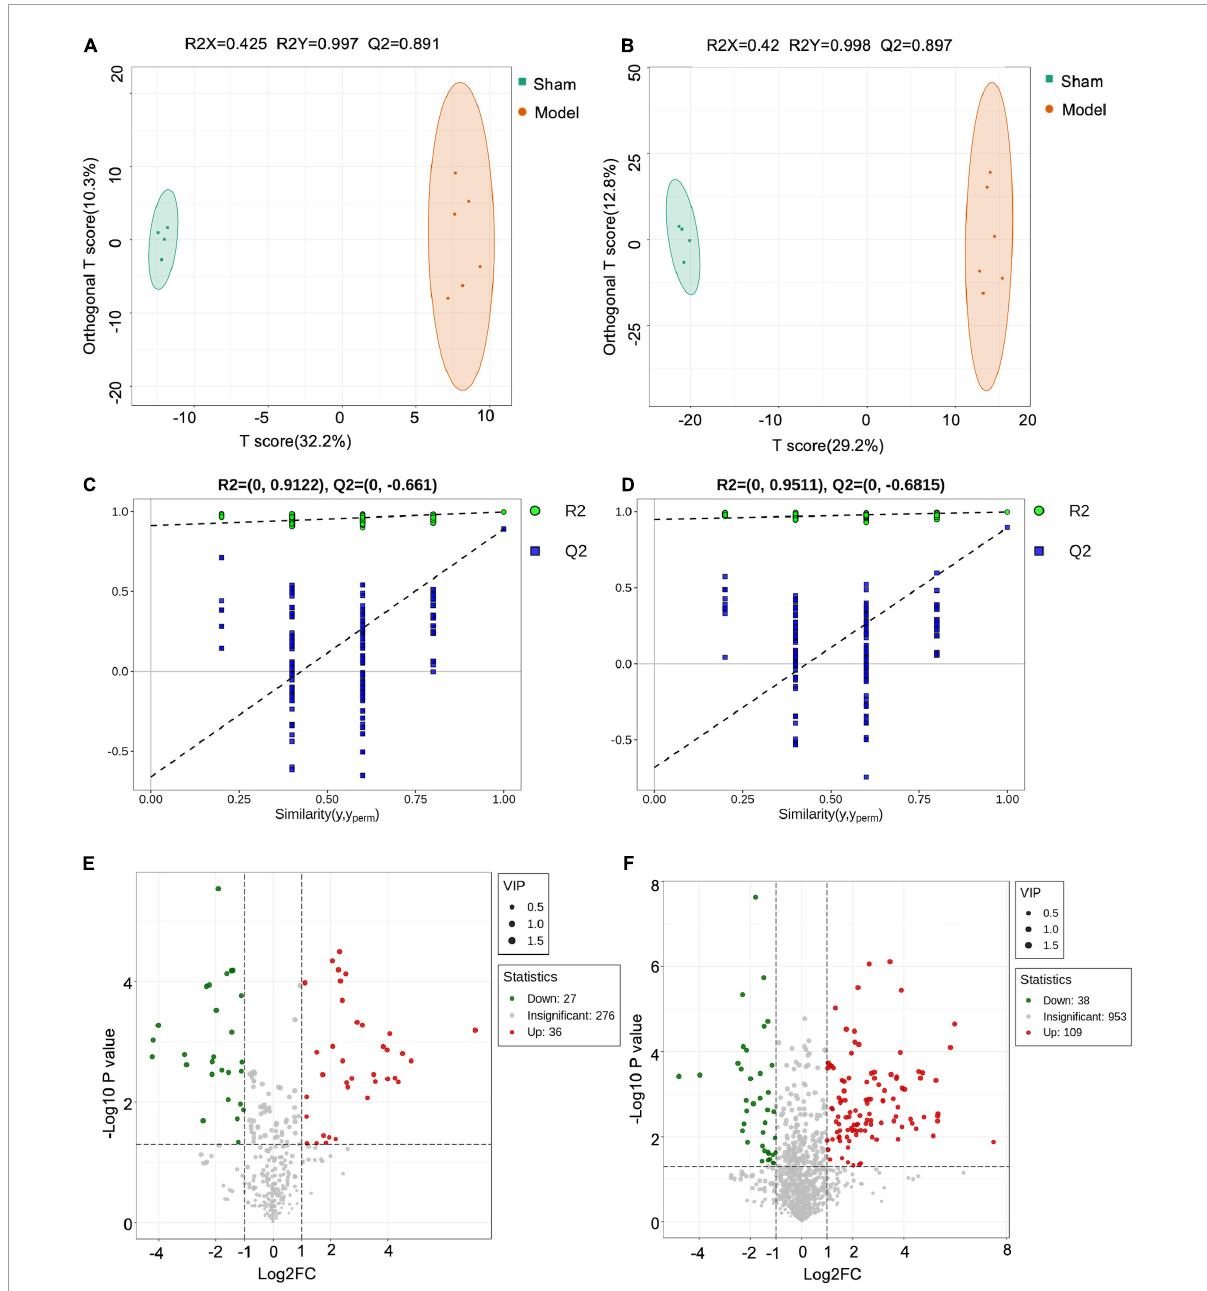
FIGURE5 Orthogonal PLS-DA analysis (OPLS-DA) analyses. Negative OPLS-DA score plots (A) ; positive OPLS-DA score plots (B) ; negative scatter plots of the statistical validations obtained by 200 × permutation tests (C) ; positive scatter plots of the statistical validations obtained by 200 × permutation tests (D) ; negative volcano plot (E) ; positive volcano plot (F)